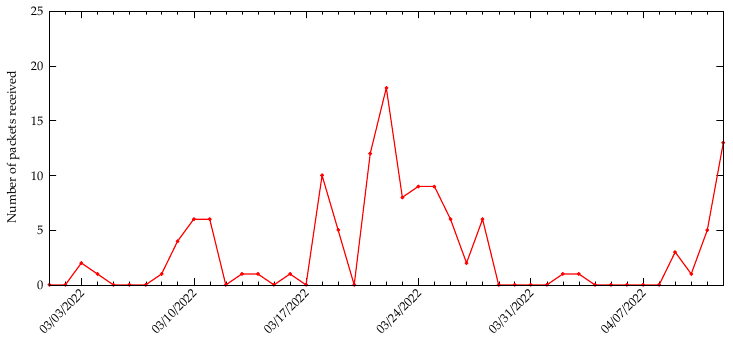
Figure 14. Number of packets received per day from the energy-harvesting node during the period from 1 March 2022 to 12 April